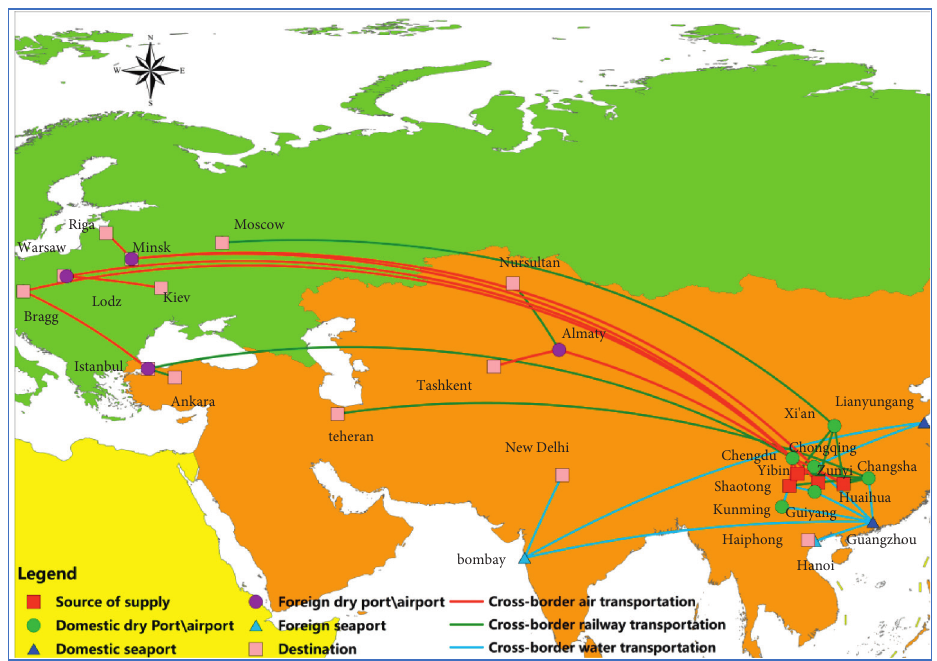
Figure 8: The optimal cross-border logistics paths in southwest